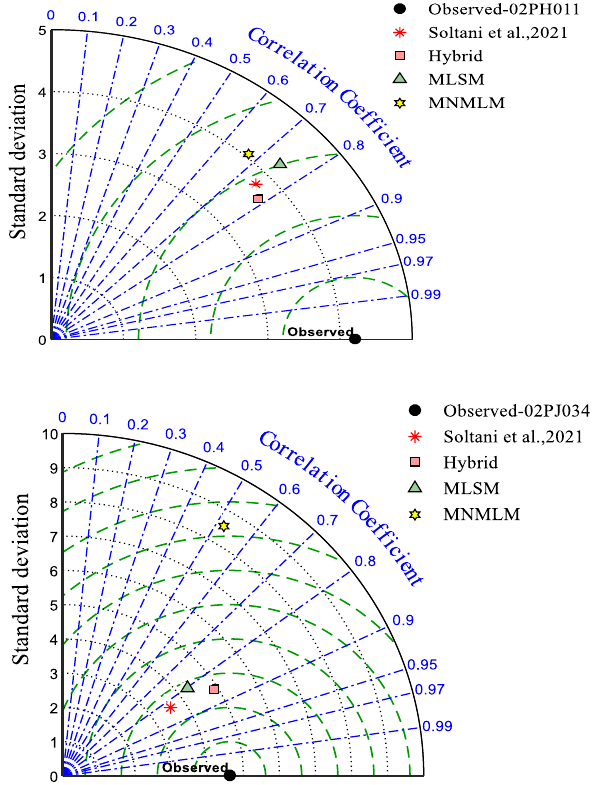
Fig. 9 Taylor diagram for observations of four model estimates of the monthly runoff for 02PH011 and 02PJ034 stations in the study